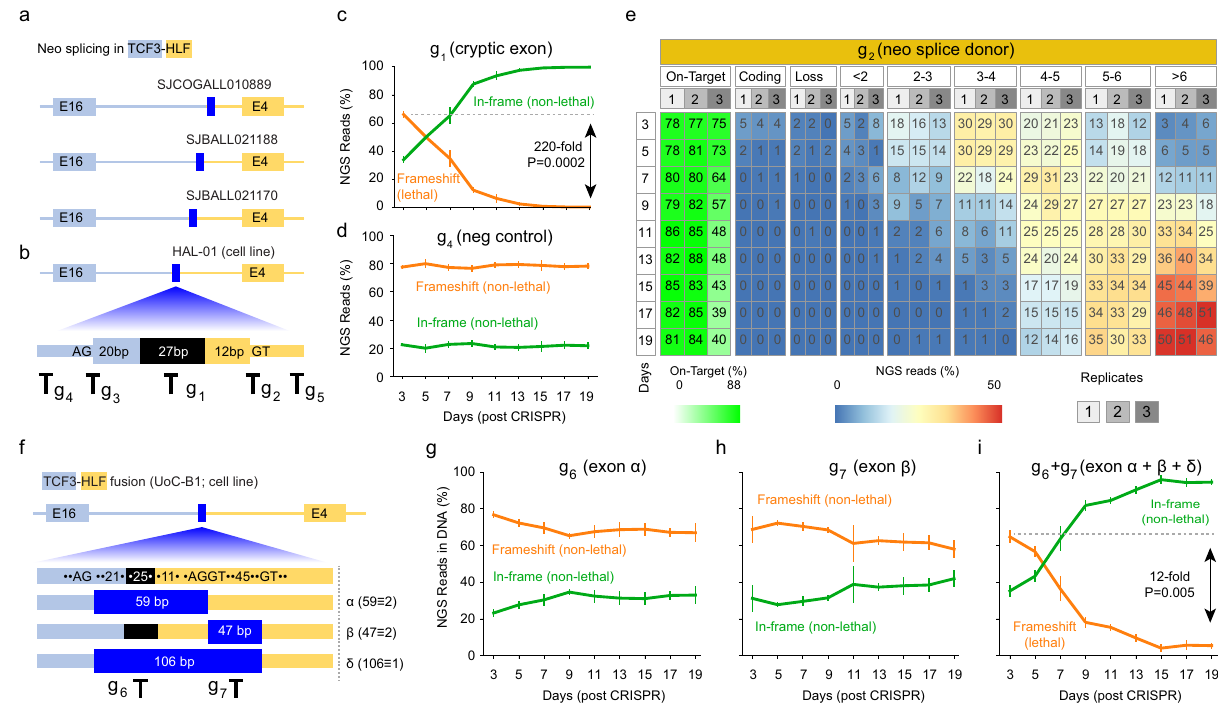
Fig. 6 | Neo-splicing in oncogenic fusions and genome-editing-based ther- apeutictargeting.a In our cohort, all samples with TCF3 - HLF fusions harbor neo- splicing events due to incompatible exon frames between TCF3 exon 16 and